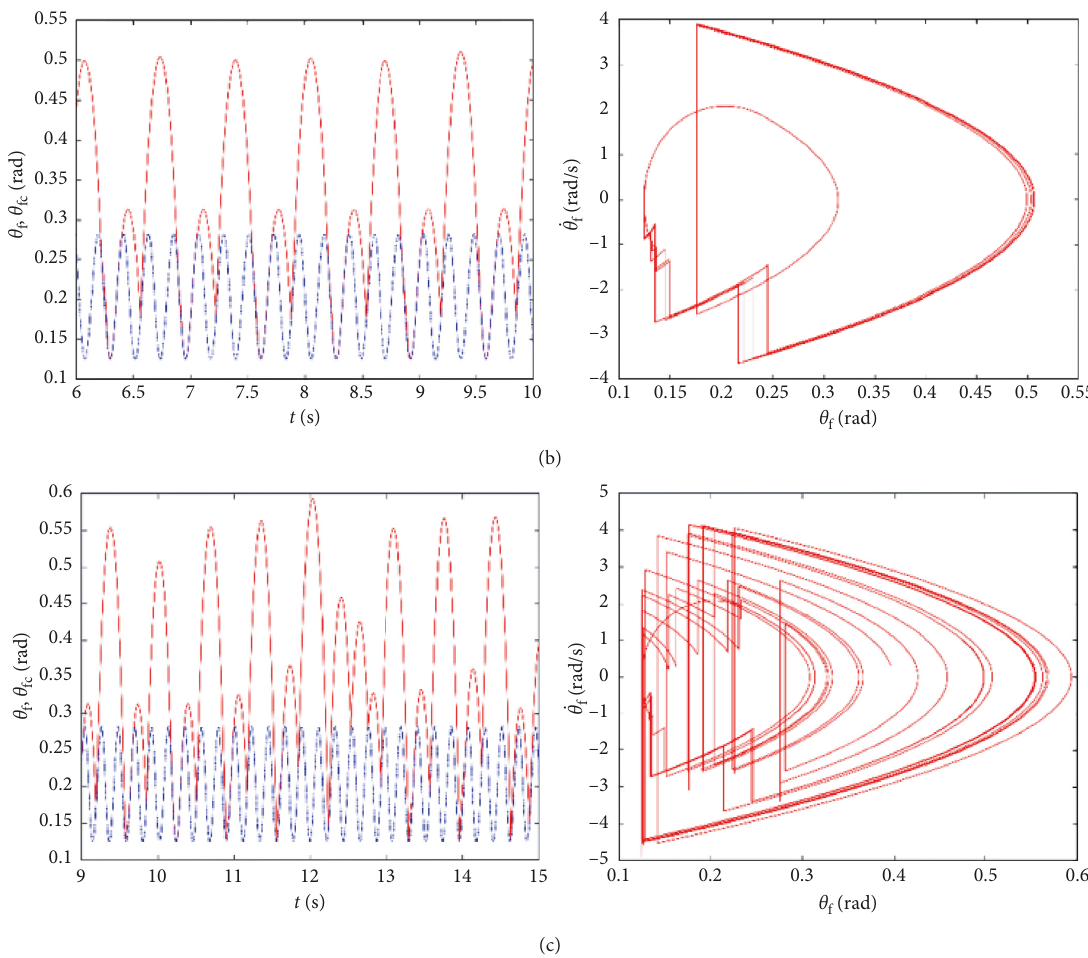
Figure 7: System response with different contact line length distributions ( μ � 0 . 008 m). (a) Quasiperiod 2 ( σ � 0 . 001 m; left frame: red , blue represents θ ). (b) Quasiperiod 2 ( σ � 0 . 002 m; left frame: red represents θ represents θ f fc left frame: red represents θ , blue represents θ f fc